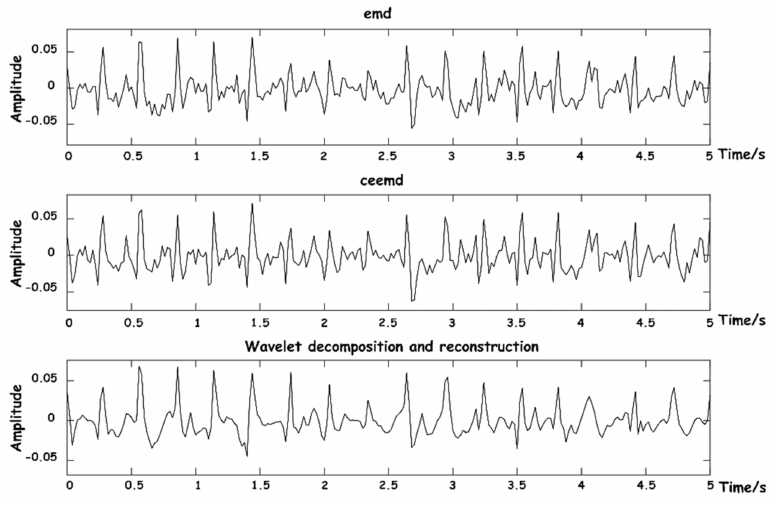
Figure 10. Diagram of BCG signal reconstruction effects.